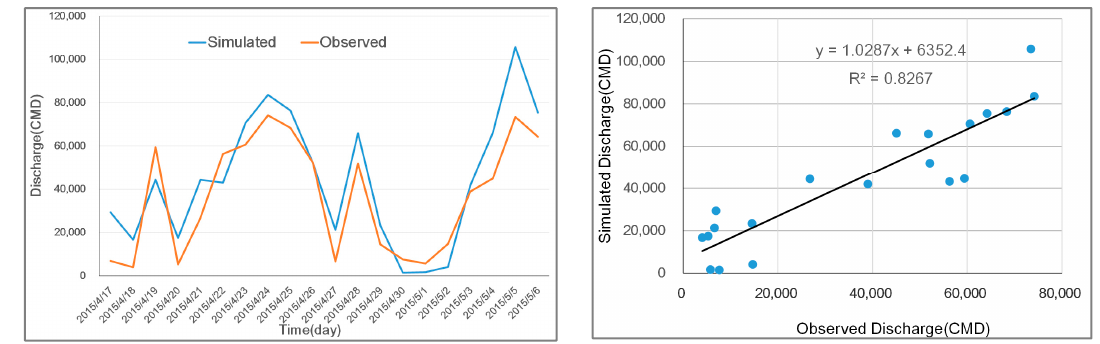
Figure 13. The comparison between observed and simulated discharge (CMD: Cubic Meters per Day, R 2 : coefficient of correlation).